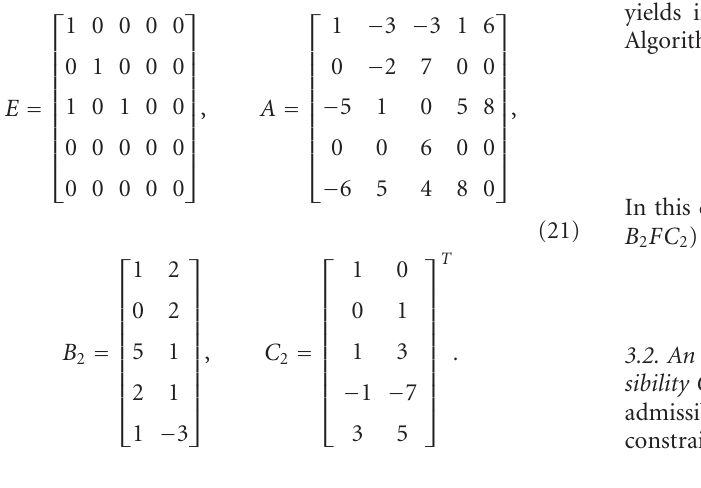
Algorithm 6 yields initial variables P s and S s after 2 iterations.